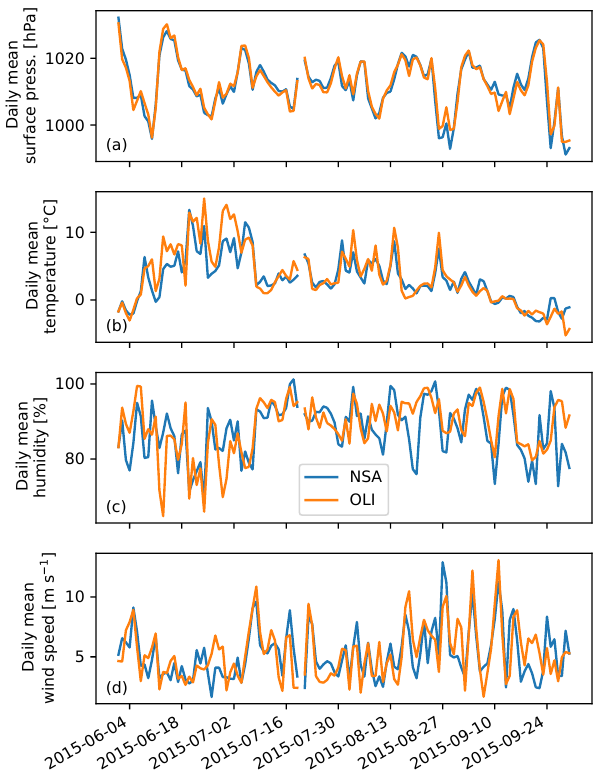
Figure 2. Comparison of daily mean values for (a) surface pressure, (b) 2m temperature, (c) 2m humidity, and (d) 10m wind